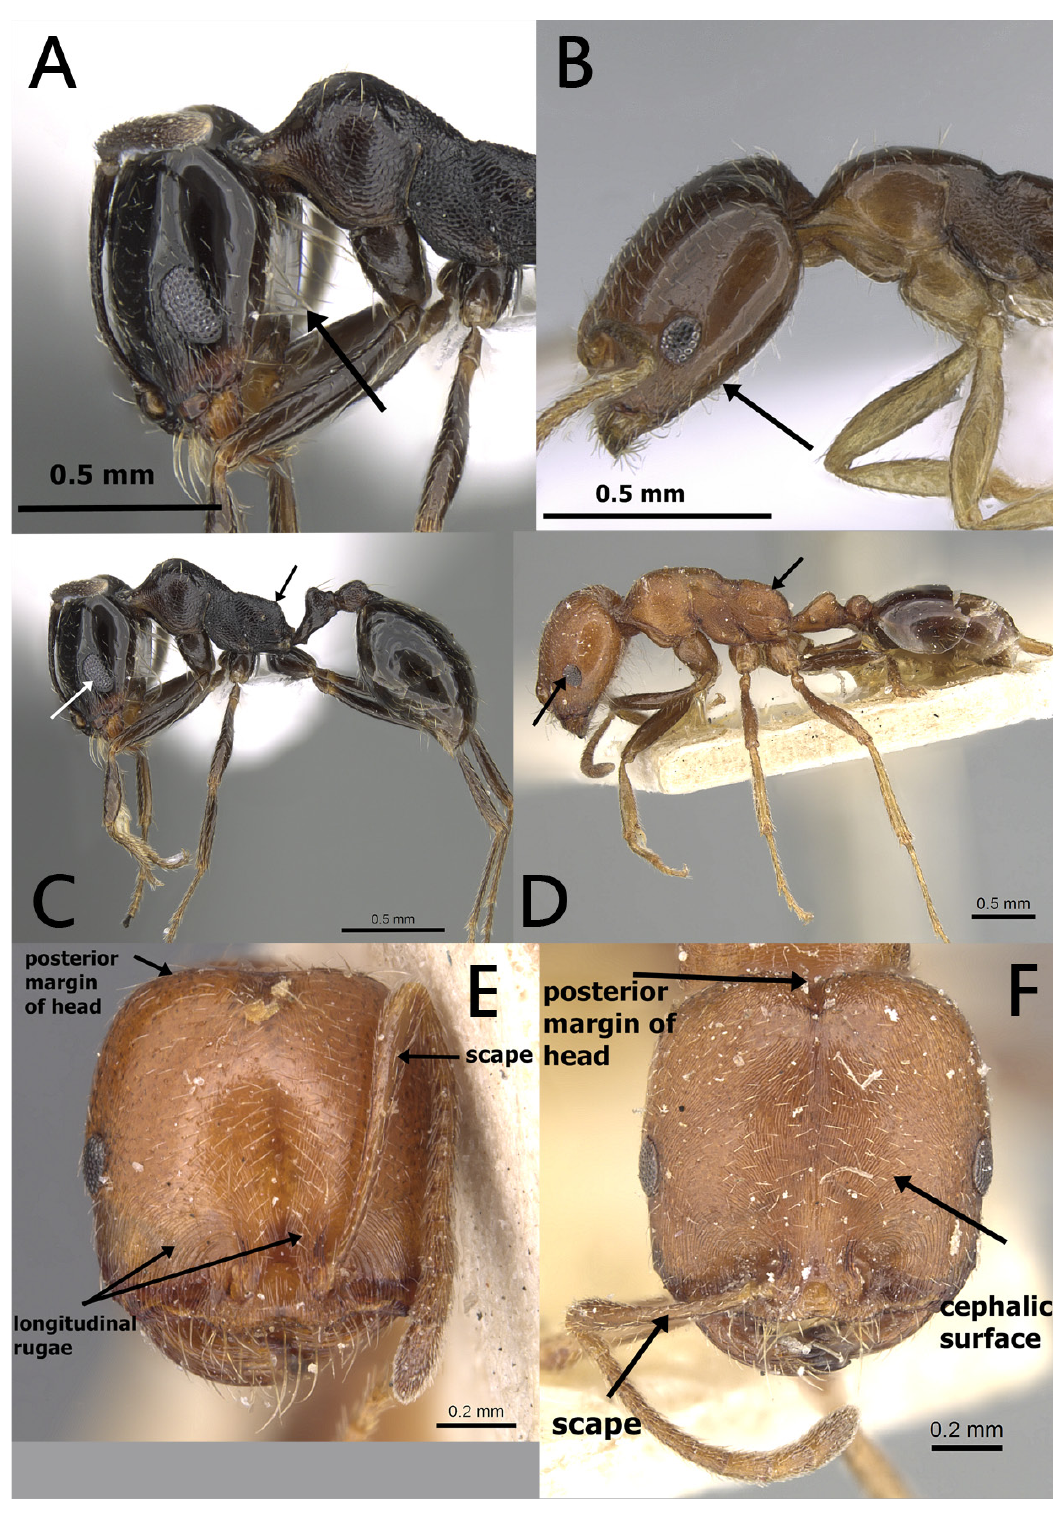
Fig. 1. A . Head of Trichomyrmex almosayari sp. nov. showing psammophore. B . Head of T. mayri (Forel, 1902) showing absence of the psammophore. C . T. almosayari sp. nov., body in profile. D . T. lameerei (Forel, 1902), body in profile. E . T. chobauti (Emery, 1897), head in full-face view. F . T. lameerei , head in full-face